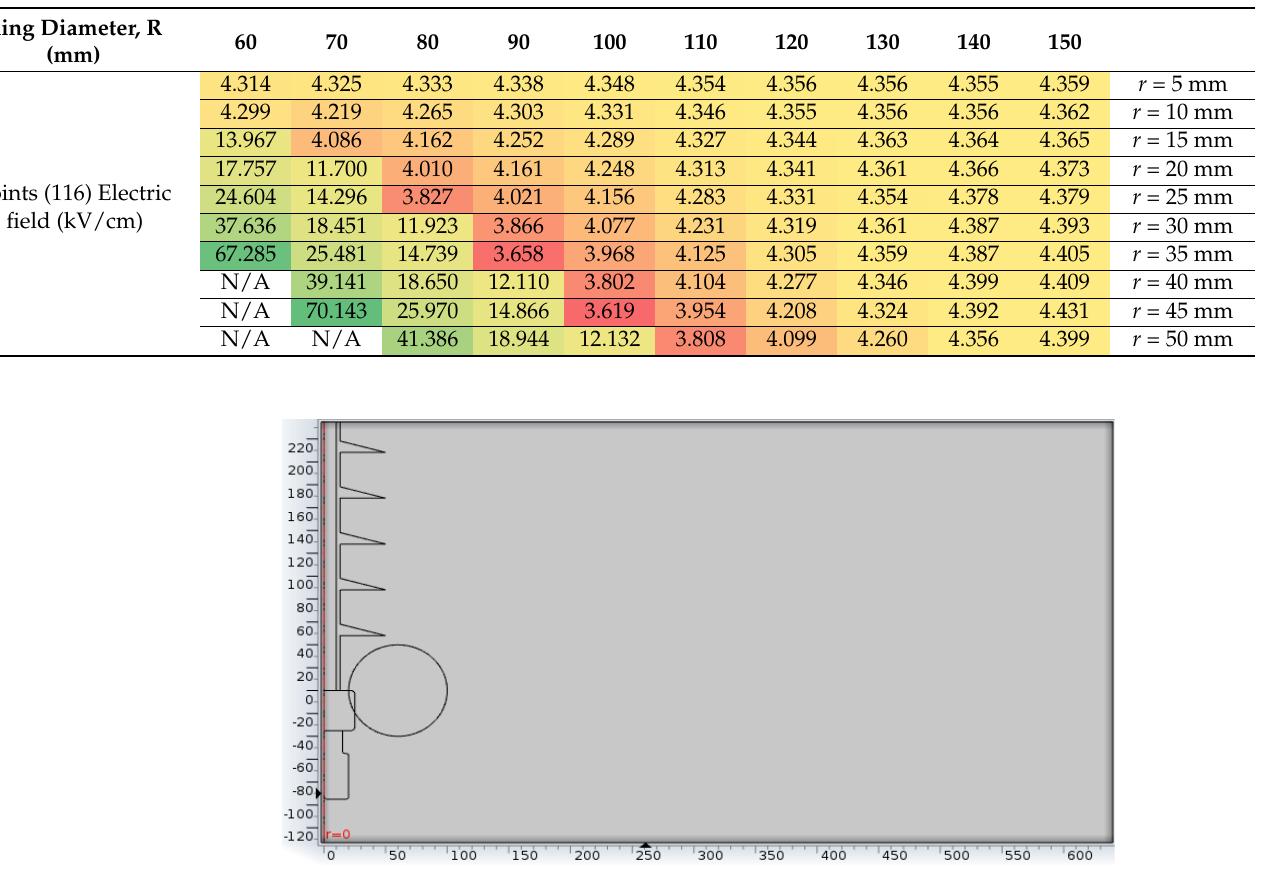
r = 25 mm r = 45 mm Figure 11. Electric field distribution with variation in diameter of ring tube, r. 3.3. Optimisation Results Using ICA and GWO for 132 kV Insulator String Two different non-linear optimisation techniques, the Imperialist Competitive Algo- rithm (ICA) and Grey Wolf Optimisation (GWO), were used to obtain the lowest electric field magnitude for a 132 kV insulator string. For this model, a GSA technique is not ap- plied because its optimisation results are not suitable for a higher applied voltage. The results achieved from the model of the insulator string with the corona ring were com- bined with the MATLAB script to achieve the objective function. The results from the ICA and GWO are compared and explained. There are few dimensions used on the corona ring and insulator string. The main ring dimensions in the corona ring model are the ring diameter R , the vertical position of the ring along the insulator H and the diameter of the ring tube r . These parameters are optimised by the ICA and GWO in order to achieve the lowest electric field along the insulator string. Three cases were evaluated in this optimisation work. For case 1, the dimension which needs to be optimised is the diameter of the ring tube, r . For case 2, the dimensions for both the diameter of the ring tube, r, and the ring diameter, R, of the corona ring are optimised. For case 3, it is the diameter of the ring tube, r , the ring diameter, R, and the height of the ring, H . Table 5 shows summarised descriptions of all the case studies while Figure 12 shows the materials and domains that were optimised.